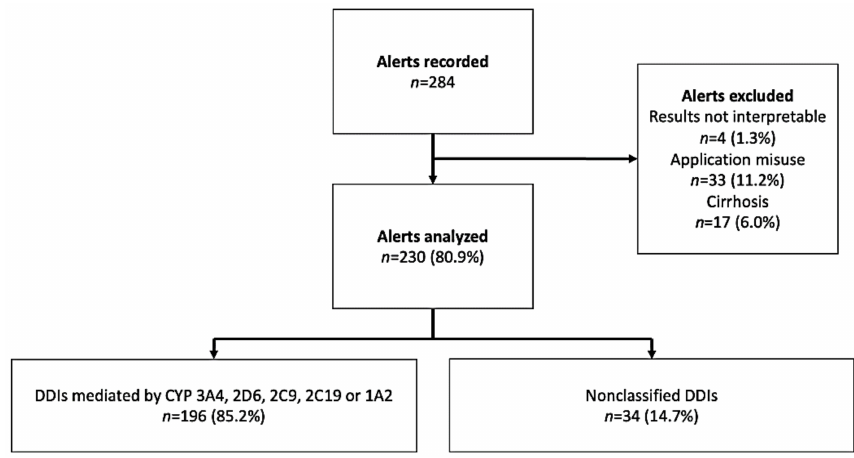
Figure 1. Study flow chart for DDIs. The tools’ detection rates differed significantly: 92 out of 230 (40.0%), 176 out of 230 (76.5%), and 196 out of 230 (85.2%) for the ANSM thesaurus, the GUH table, and DDI-Predictor, respectively ( p < 0.0001). The results are summarized for inducers and inhibitors in Table 1, with the ANSM thesaurus as the reference. Table 1. Comparison of the three tools’ respective abilities to detect DDIs. Numbers not in italics refer to DDIs involving enzyme inducers, whereas numbers in italics refer to DDIs involving enzyme inhibitors. According to the ANSM thesaurus, the strength/risk level of a DDI is categorized as 1: a contraindicated drug combination; 2: an at-risk drug combination; 3: a drug combination to be administered with caution; or 4: an interaction to be taken into consideration. In the GUH table, weak and strong interactors are referred to as “i” or “I”, respectively, and weakly and strongly metabolized drugs are referred to as “m” or “M”, respectively. The strength of the DDI is then categorized as I/M (1), I/m (2), M/i (3), i/m (4), ND (not detected) or NR (not recorded). The R AUC is quoted as the mean ± standard deviation. ANSM GUH